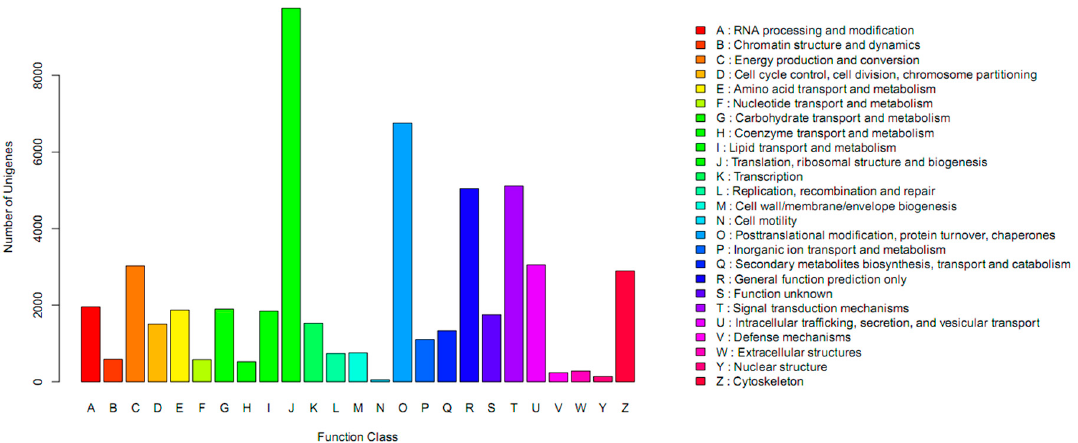
Figure 3. The GO classification of the assembled transcripts.